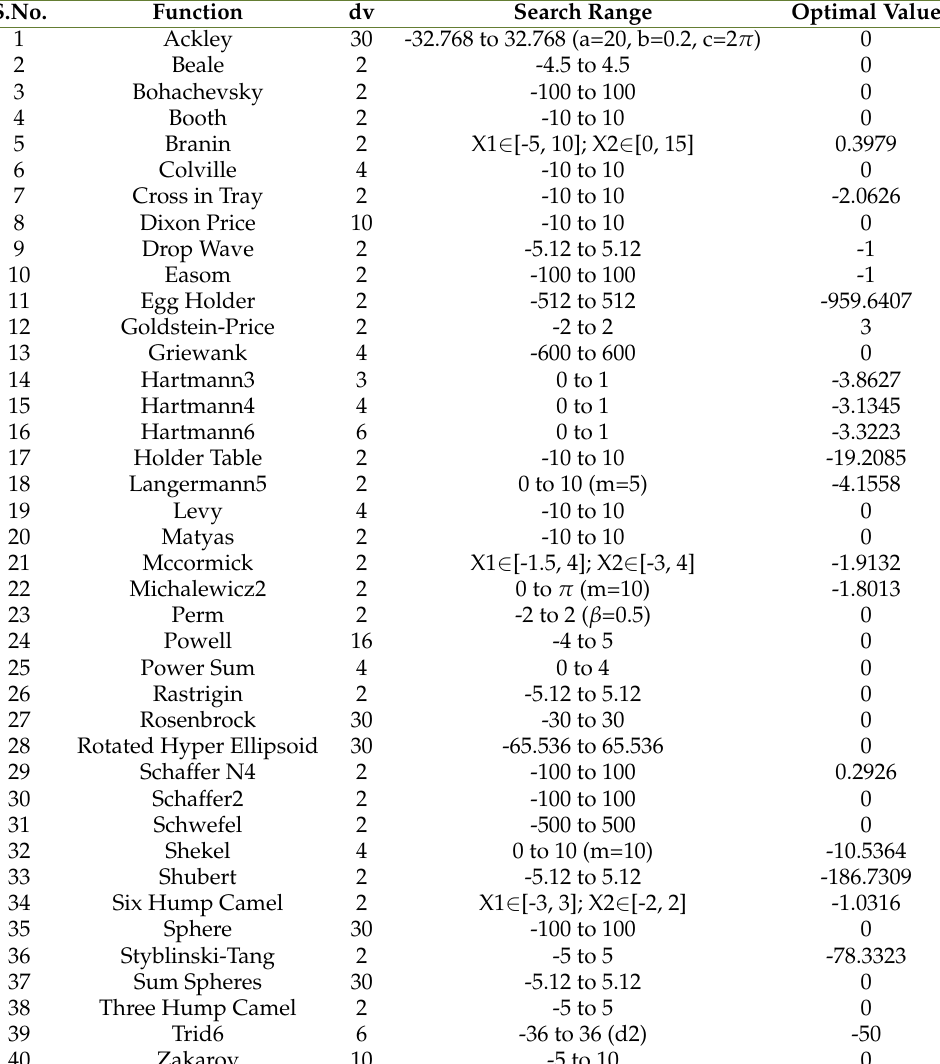
Table 1. Benchmark Functions (Unconstrained